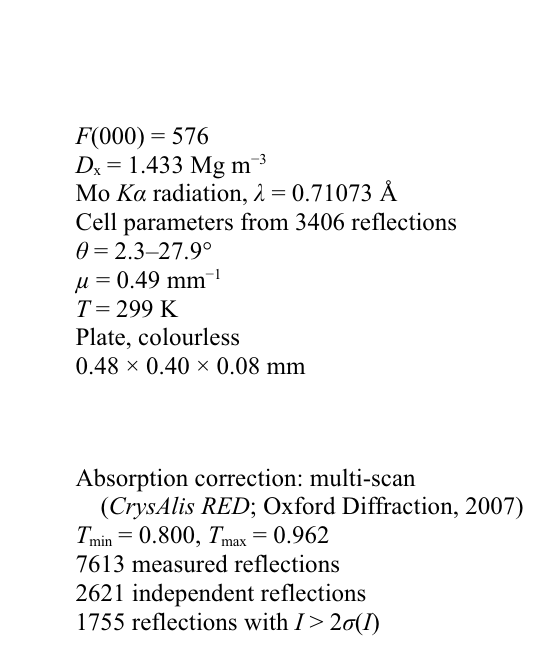
Molecular packing of the title